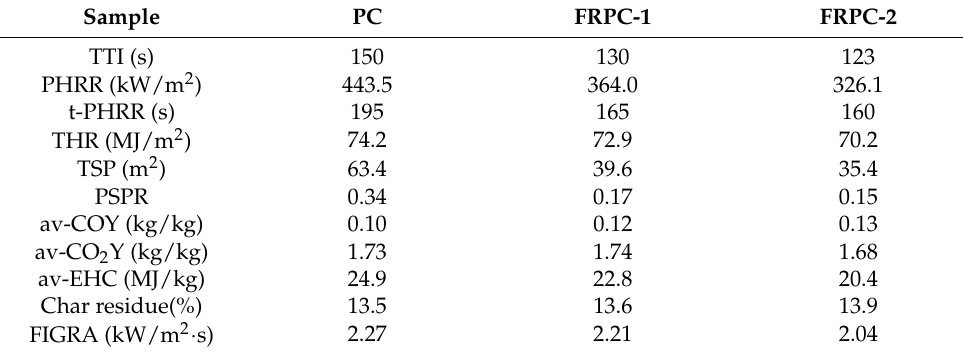
Figure 3. HRR ( a ), THR ( b ), SPR ( c ) and TSP ( d ) curves obtained from CCT. Table 3. Cone calorimeter parameters of PC and FRPCs.